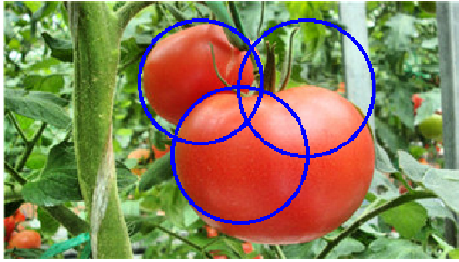
Figure 17. A false positive